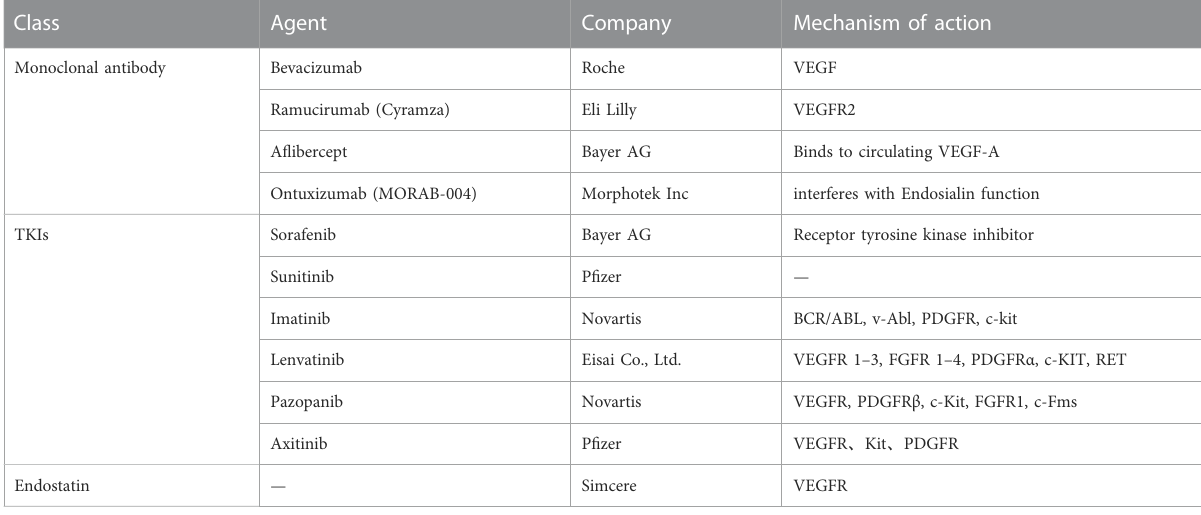
TABLE 1 Summary of clinical stage and ongoing evaluation of anti-angiogenic agents in melanoma.